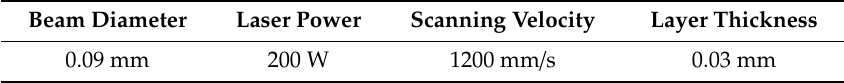
Table 2. The process parameters for LPBF (Laser Powder Bed Fusion) of TNM